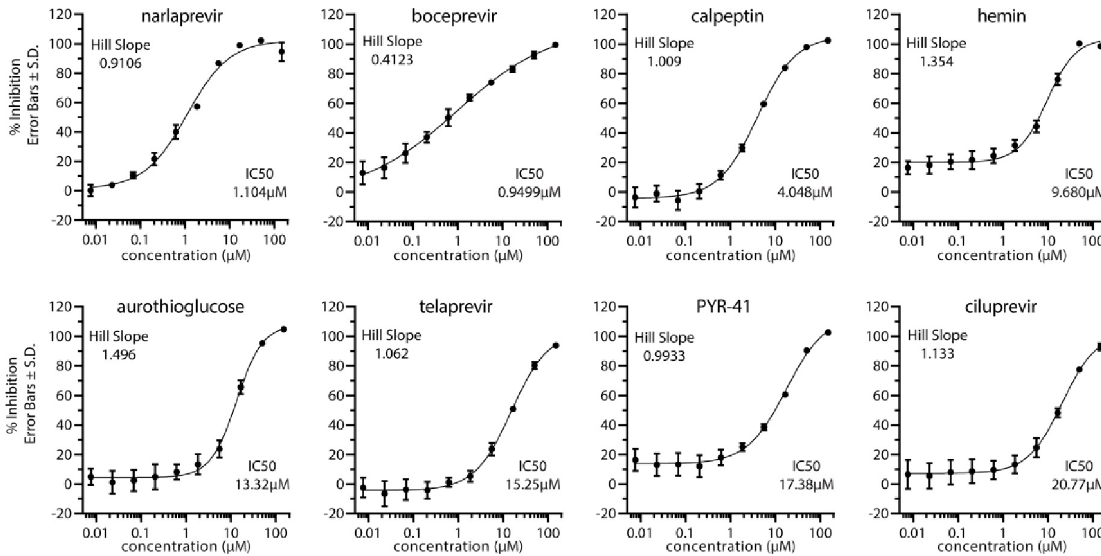
Fig 3. Dose-response validation of compounds against SARS-CoV-2 Mpro. Dose response curves were generated using Ac-Abu-Tle- Leu-Gln-AFC substrate. Percent inhibition of each compound was calculated at indicated 10 concentrations by comparing slope of treatment versus DMSO control. Error bars represent standard deviation and n = 3 for each concentration. IC50 values and Hill Slopes are indicated and calculated by 4-parameter nonlinear regression curve